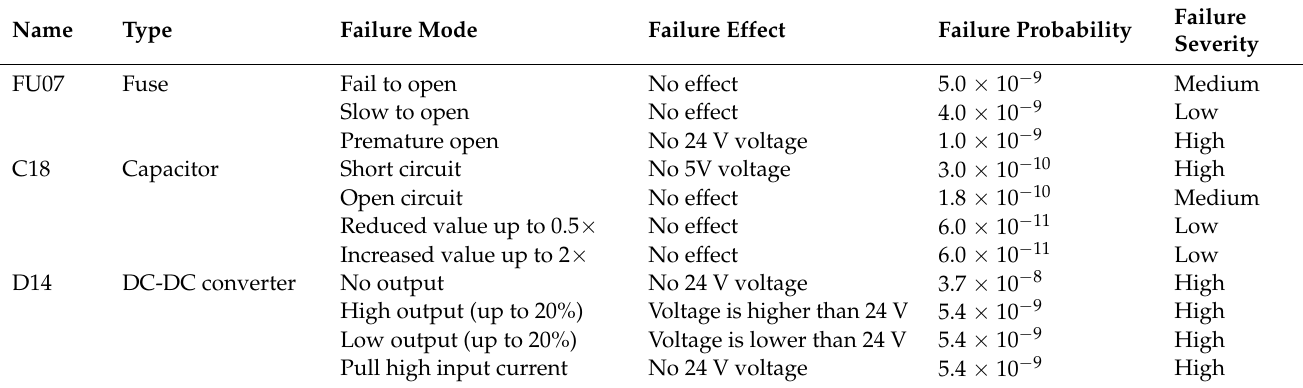
Table 8. FMECA example prepared by expert